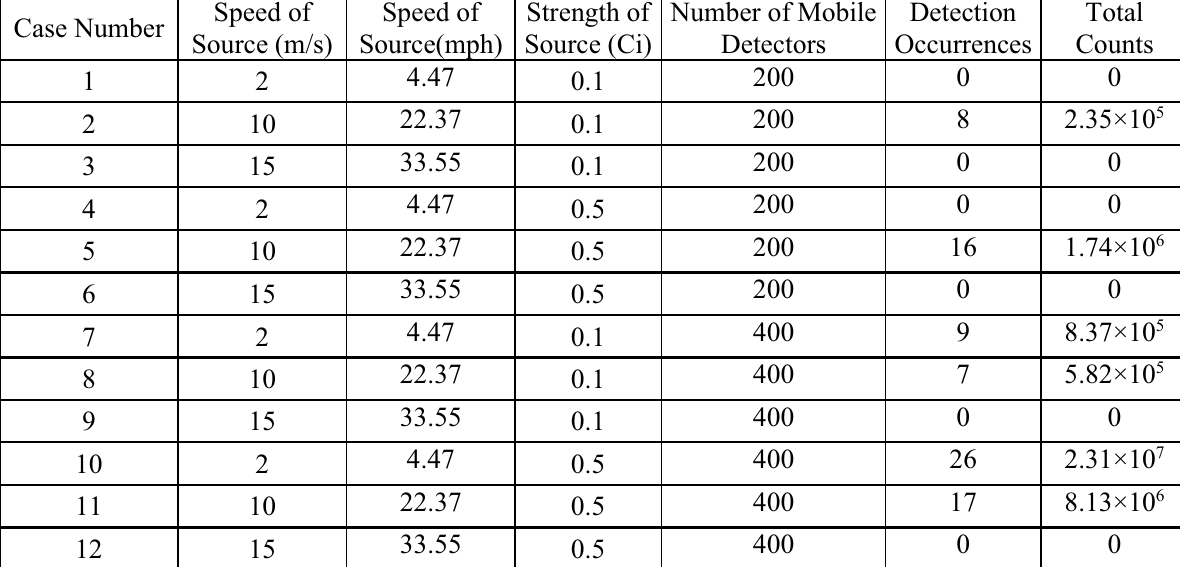
Table I. Case Study Parameters and Results: 12 cases were simulated with varying source speed and strength for 200 or 400 detectors. Source paths were identical in each case. Mobile sensors followed 200 or 400 identical